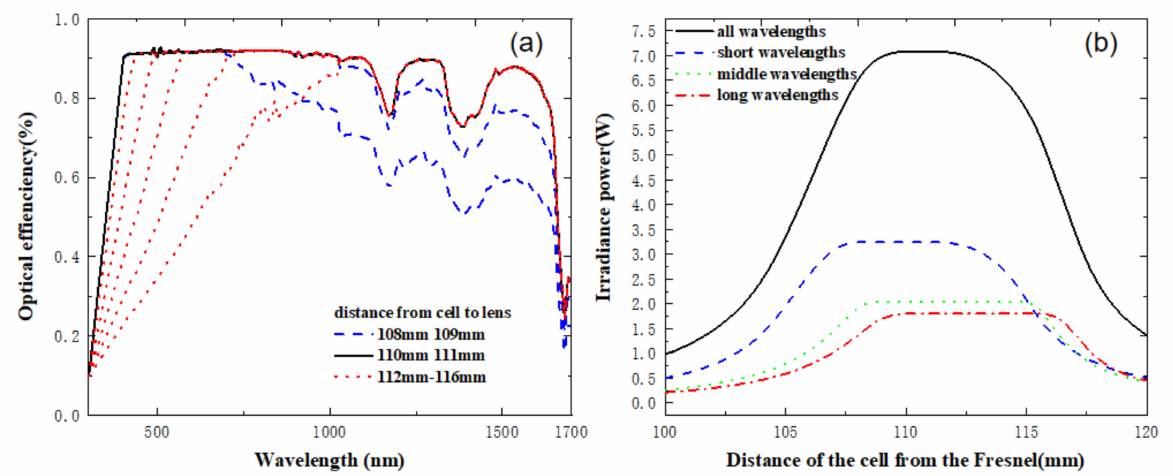
Figure 4. ( a ) Optical efficiency at different optical axis positions (in the range of 300–1700 nm); ( b ) Radiation power at different positions in the optical axis